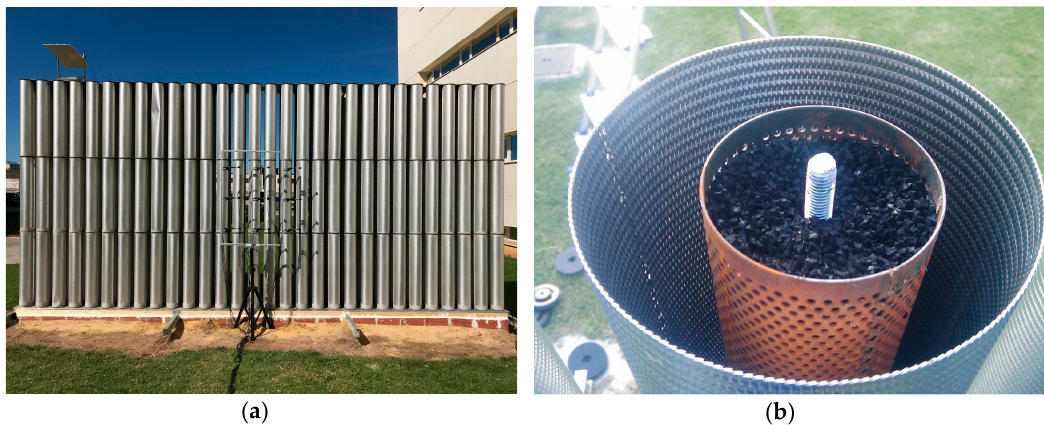
Figure 1. Sonic crystal (SC) barrier sample implemented on the campus of Universitat Politècnica de València: ( a ) Appearance of SC barrier sample made of three rows of absorbing cylindrical units, along with experimental setup; ( b ) internal cross-section of a cylindrical unit, consisting of a porous core made of rubber crumb and outer micro-perforated aluminium shell.